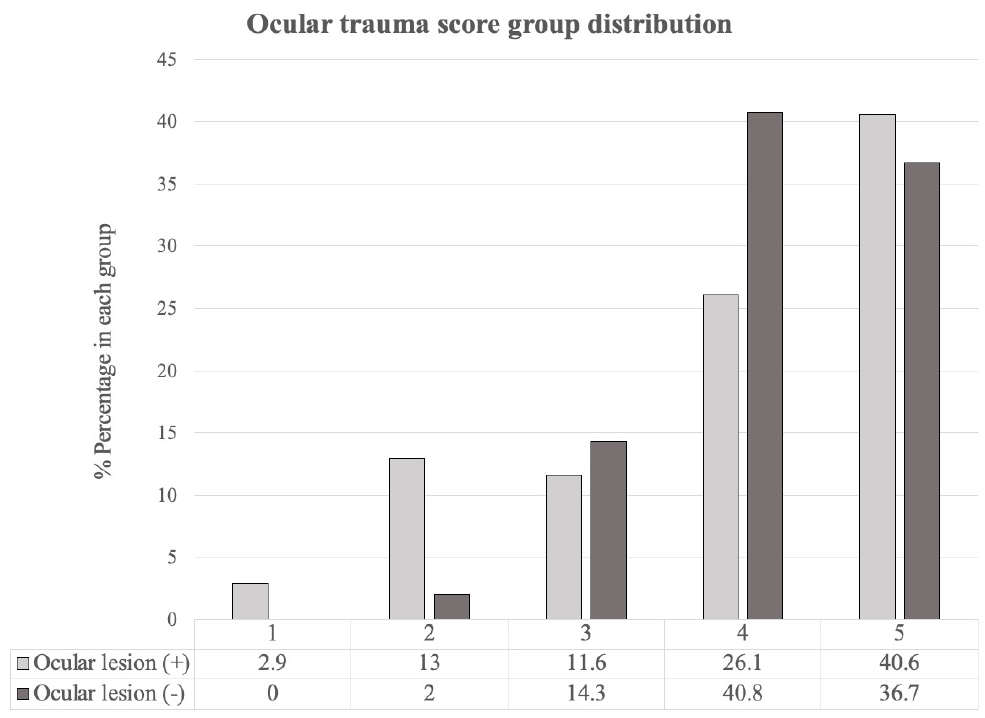
Figure 2. Distribution of the ocular trauma score in blunt head injury